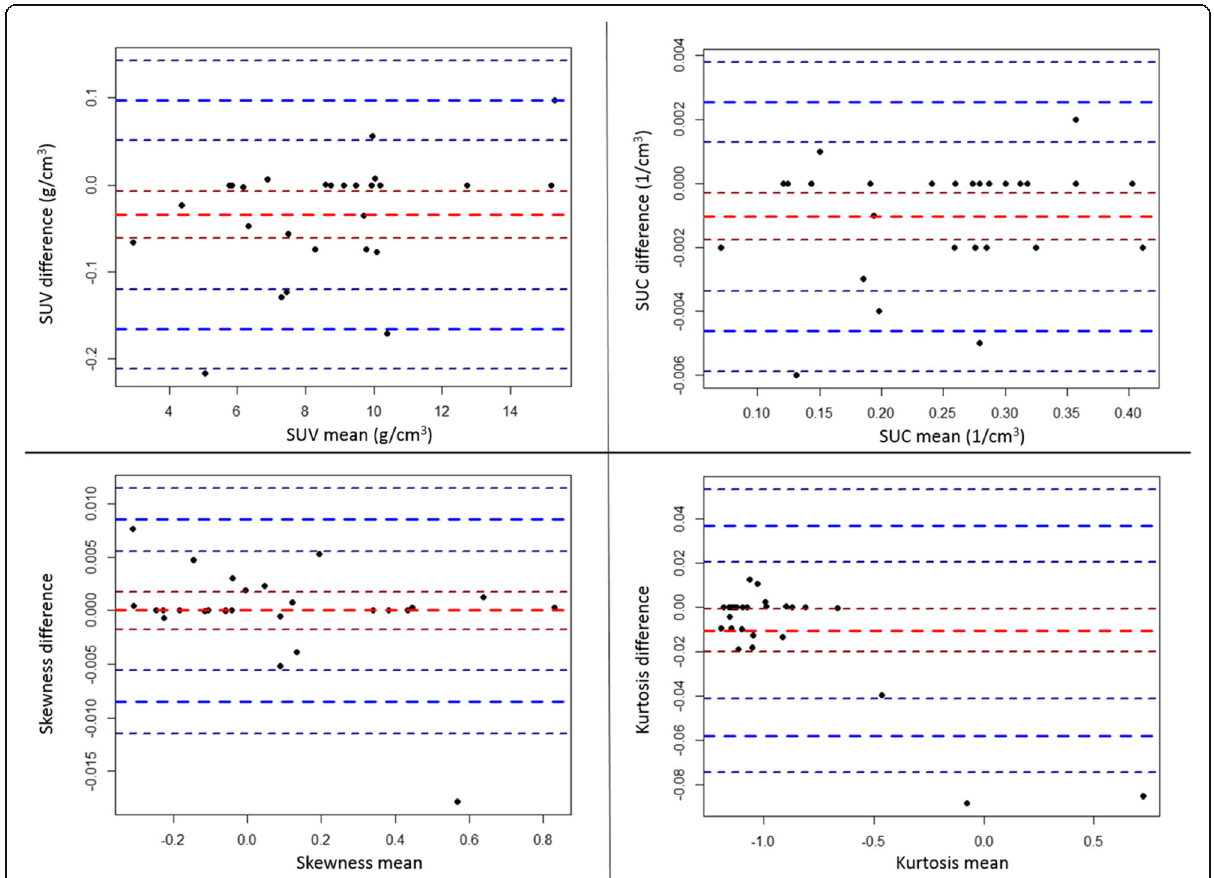
Fig. 2 Difference plot for each parameter. Red line: mean of differences (with 95% confidence interval). Blue lines: 95% limits of agreement (with 95% confidence intervals)